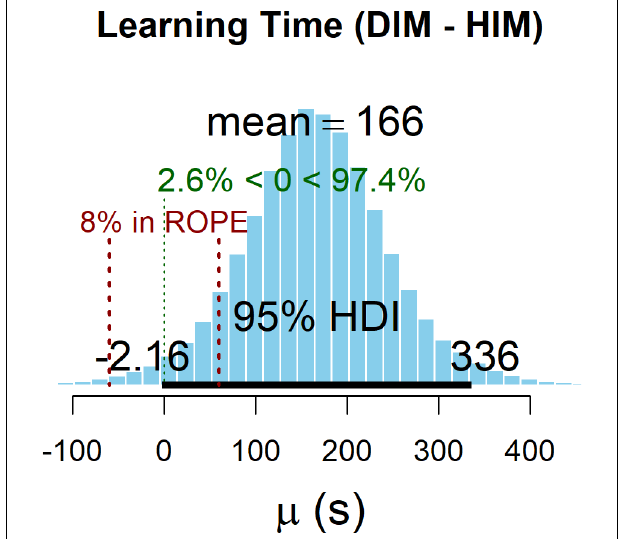
FIGURE 8 | Posterior distribution for the effect of interface on learning. The ROPE is indicated in red and was set to correspond to a ± 60 s of learning time. This figure was created using the BEST package (Kruschke and Meredith,